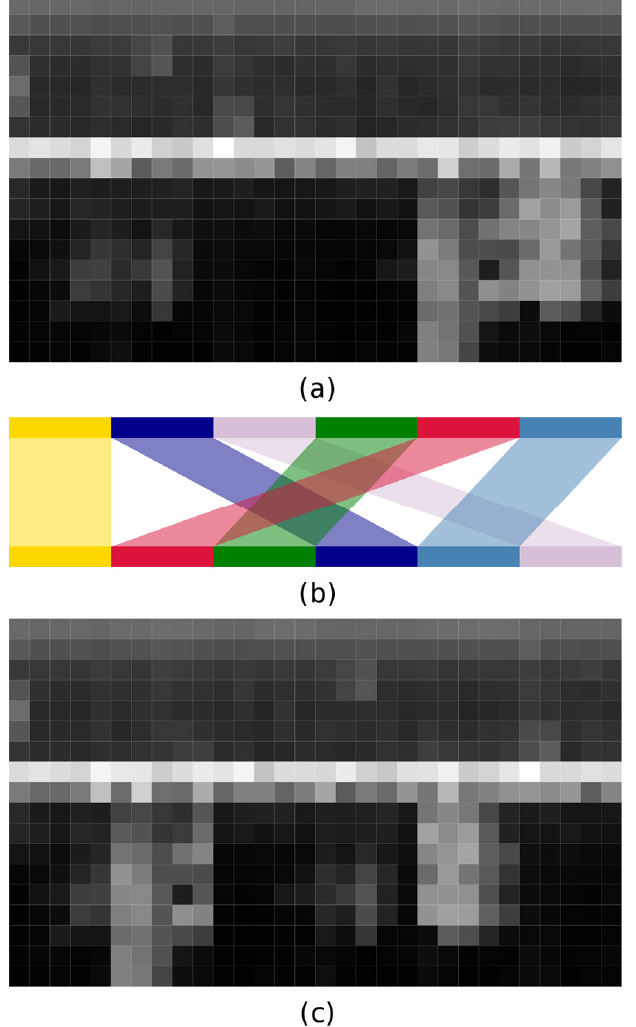
Figure 1. We performed the process used for data augmentation by slicing and rearranging. ( a ) The initial features extracted from the audio file were arranged in a matrix. ( b ) This matrix was sliced into six pieces on the time axis. ( c ) These slices (highlighted with different colours) were then randomly rearranged to create novel input data.